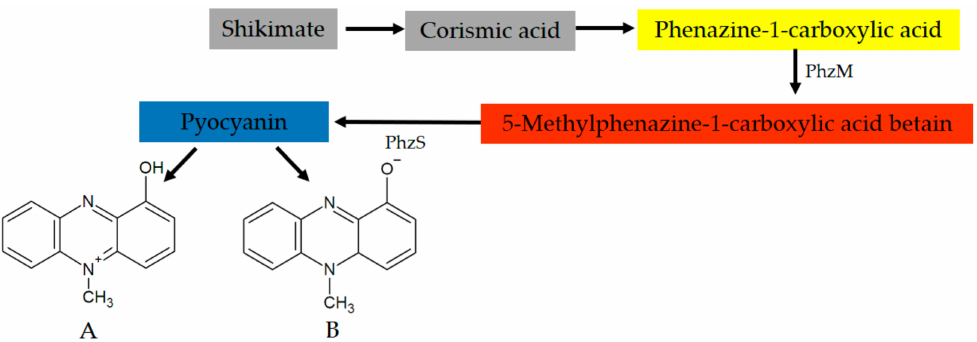
Figure 1. Steps of the biosynthesis of pyocyanin by Pseudomonas aeruginosa and its oxidated ( A ) and reduced ( B )